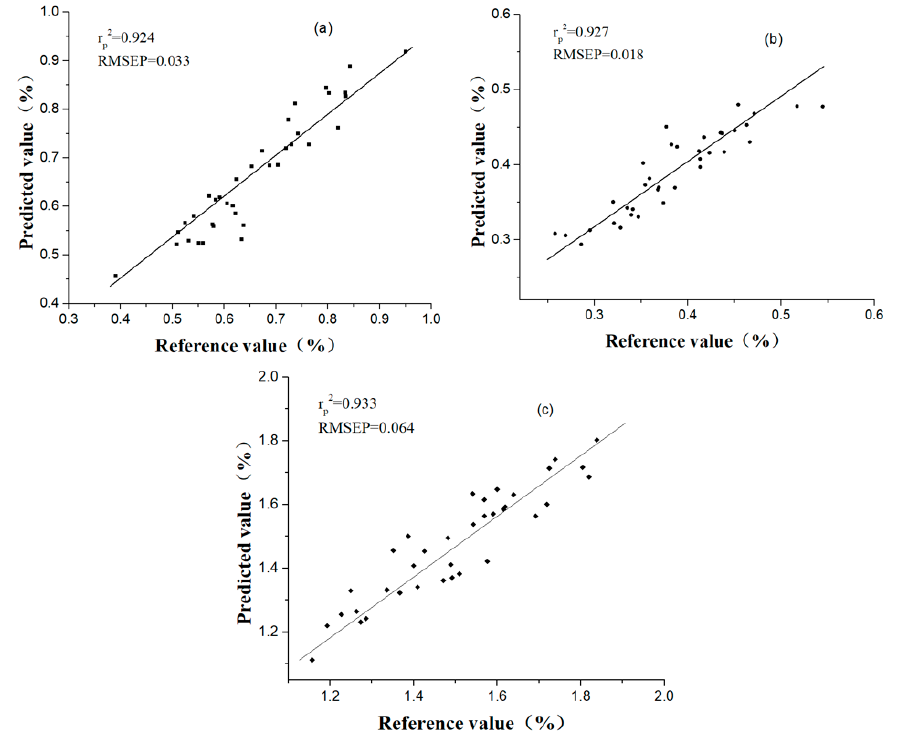
Figure 3. Results of CARS-BP-ANN models in the prediction set for prediction of ( a ) chlorogenic acid, ( b ) luteoloside, and ( c ) 3,5-O-dica ff eoylquinic acid.